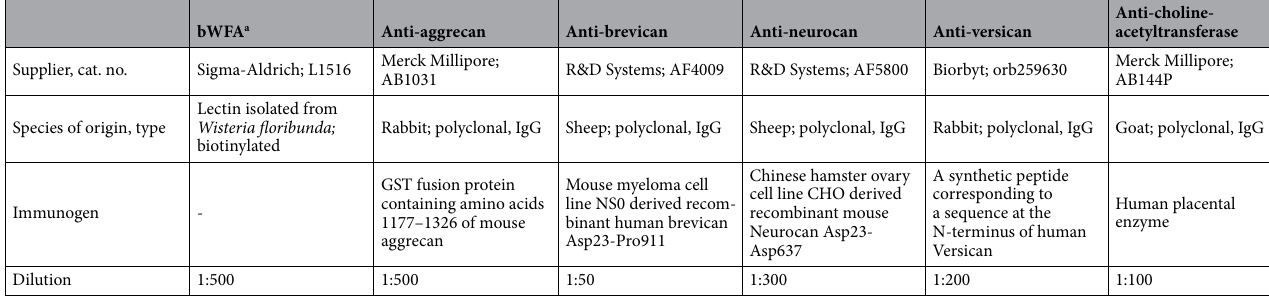
Table 1. Lectin and primary antibodies used. a Biotinylated Wisteria floribunda